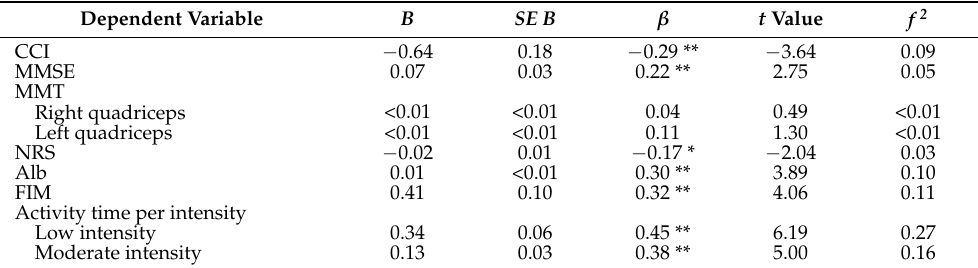
Table 3. Results of single regression analysis: empowerment affecting functioning and disability factors (N = 151).